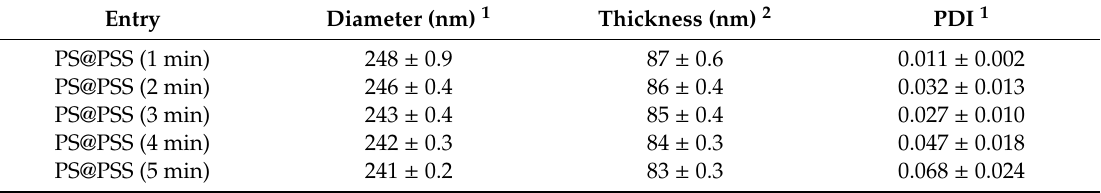
Table 3. Size of PS@PSS after homogenizer treatment under different time.